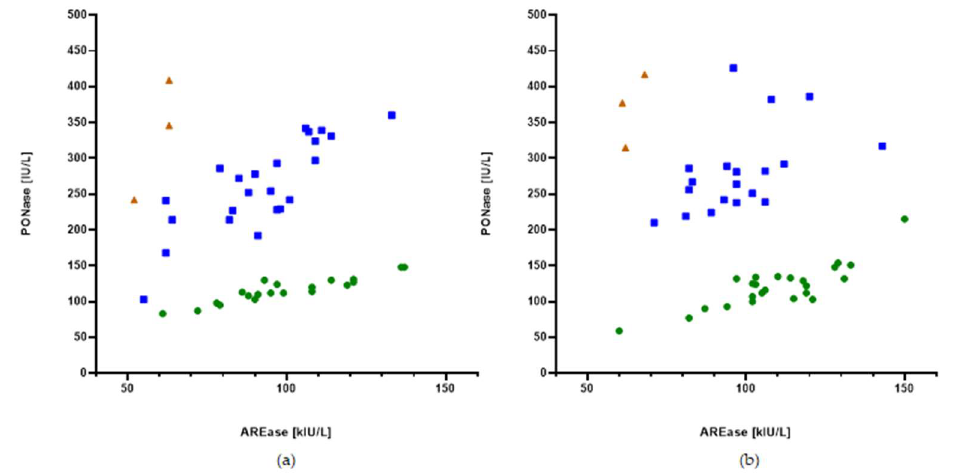
Figure 3. PONase activity toward AREase activity in the ( a ) control group and ( b ) DS group. Dots: PONase/AREase < 1.5 (green); squares: PONase/AREase = 1.5–4.0 (blue); and triangles: PONase/AREase > 4.0 (brown).